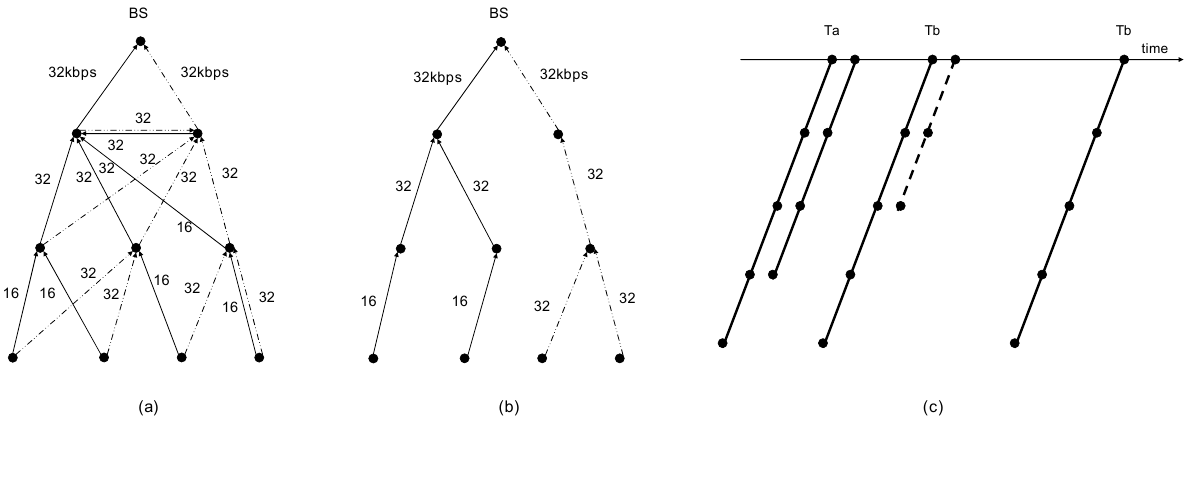
Figure 6. Bandwidth of the branch and activating sequence. (a) folded case. (b) separated case. (c) normal and temporary activating sequence of the